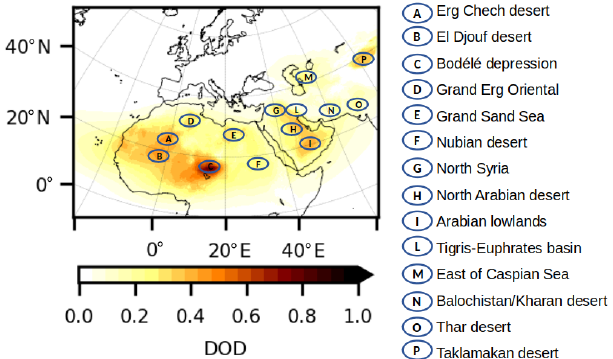
Figure 5. A number of desert, arid and semi-arid regions of inter- est for the description of the dust reanalysis. The underlying dust field is the mean 3-hourly DOD analysis calculated for the whole reanalysis period